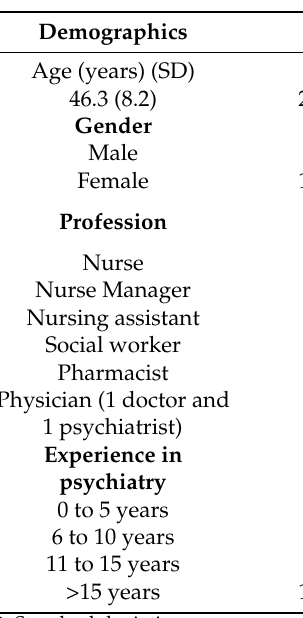
Table 2. Population